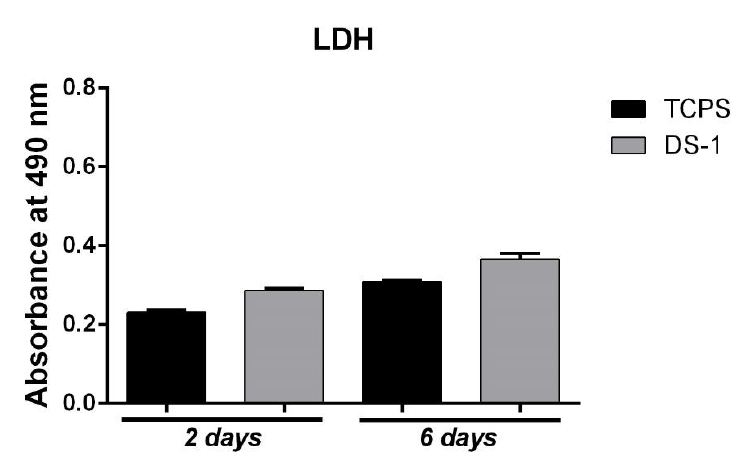
Figure 7. Cytotoxic level registered for DS-1 after two and six days of culture, evaluated by LDH assay.